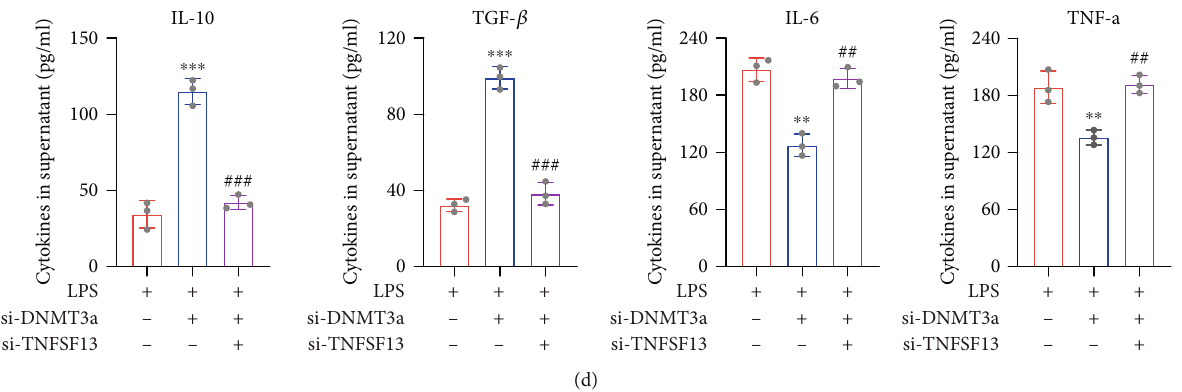
Figure 5: DNMT3a regulates IEC-induced B cell di ff erentiation through TNFSF13-mediated DNA methylation. (a) The si-DNMT3a or si-NC was transfected into IECs and then treated with LPS (1 μ g/mL) for 48h. Cells were grouped into 4 groups: IECs, IECs+LPS, IECs-si-NC+LPS, and IEC-si-DNMT3a+LPS groups. The methylation level and mRNA level in IECs and protein level of TNFSF13 in the supernatants were measured. (b) The si-DNMT3a and si-TNFSF13 were cotransfected into IECs and then treated with LPS (1 μ g/mL) for 48h. IECs were grouped as follows: IECs+LPS, IEC-si-DNMT3a+LPS, and IEC-si-DNMT3a-si-TNFSF13+LPS groups. The methylation level and mRNA level in IECs and protein level of TNFSF13 in the supernatants were measured. (c) IECs were cotransfected with si-DNMT3a and si- TNFSF13 and then cocultured with B cells. IECs were treated with LPS (1 μ g/mL) for 48h. The cocultural cells were assigned into 3 groups: IECs+B+LPS, IEC-si-DNMT3a+B+LPS, and IEC-si-DNMT3a-si-TNFSF13+B+LPS. Flow cytometry assay was conducted to detect the numbers of CD1d+ B cells and CD138+ B cells. (d) The in fl ammatory cytokines in cell supernatants were measured by ELISA. ∗∗ p < 0 : 01 , ∗∗∗ p < 0 : 001 vs. Blank or LPS group. Blank: IECs without any treatment; ## p < 0 : 01 , ### p < 0 : 001 vs. LPS+si-NC or LPS+si-DNMT3a